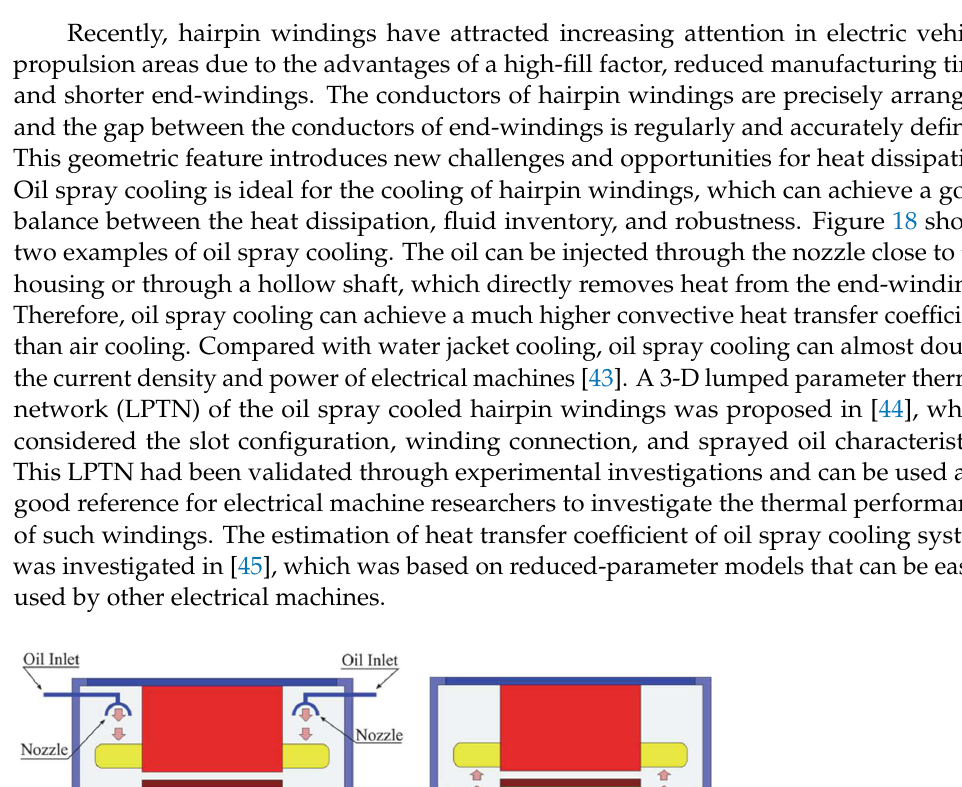
Figure 17. Schematic of the direct oil cooling for the end-winding [42]. ( a ) Slot configuration; ( b ) axial cross section.